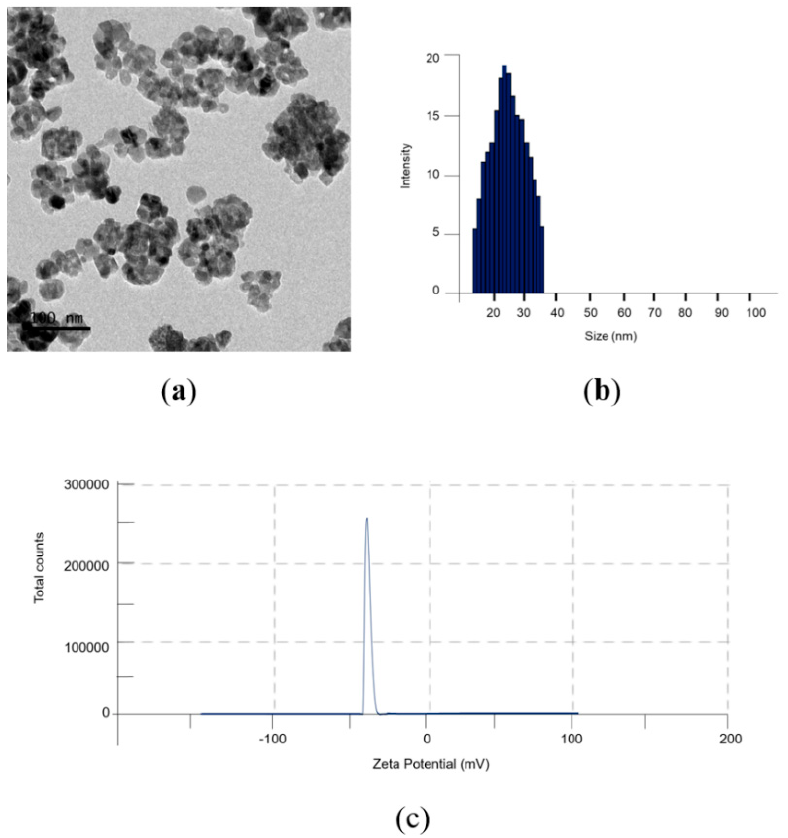
Figure 1. Characterization of TiO 2 nanoparticles (NPs) in water. ( a ) Representative TEM image, ( b ) Dynamic Light Scattering (DLS) and ( c ) ζ -potential measurements.